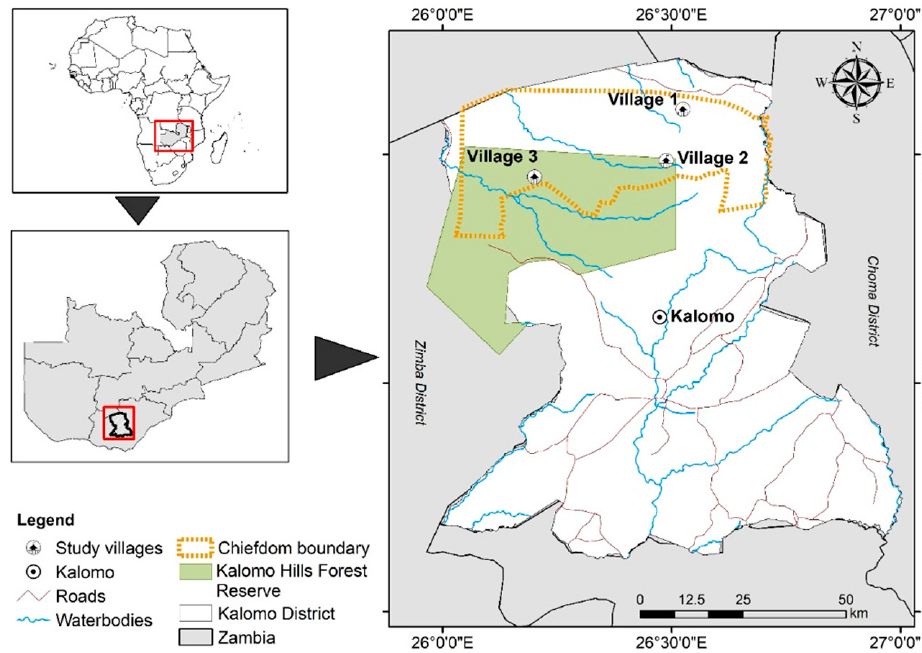
Figure 1. Location map showing Kalomo District, study villages 1 and 3 in the Chikanta Chiefdom (Source: modi fi ed from [36]).